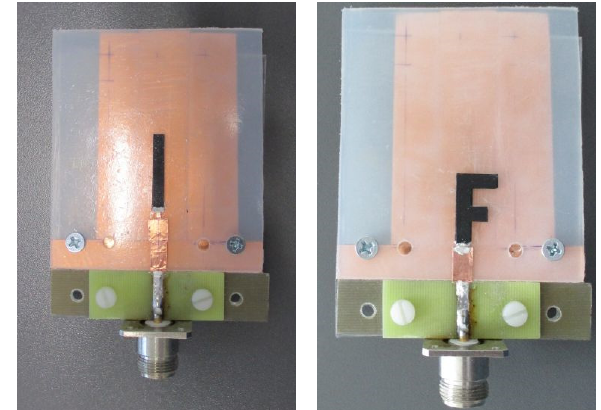
Figure 15. A photo of manufactured antennas (left: unipole; right: F-antenna).